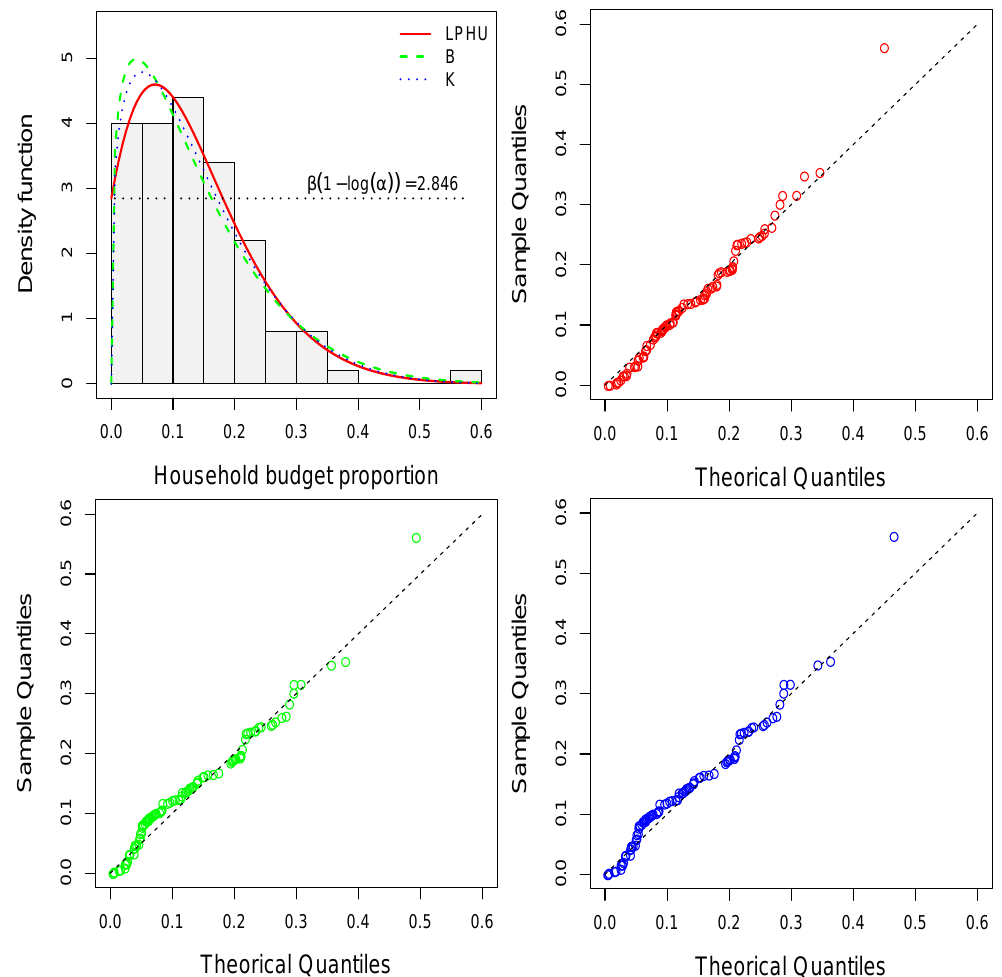
Figure 8. Top left: Histogram for a single sample obtained from the household shared budget proportion data and the fitted pdf curves via the ML method. Top right and lower: QQ-plots for the LPHU (red), B (green), and K (blue)